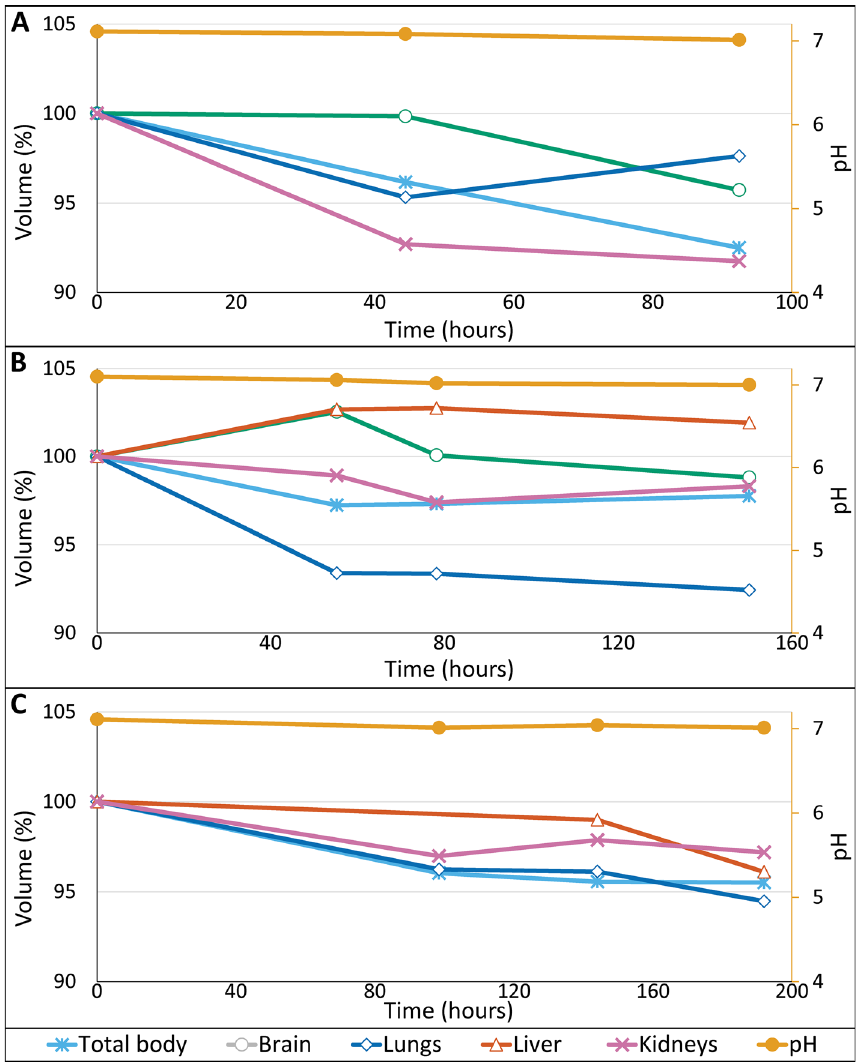
Figure 5. Three different human fetuses stained in 3.75% B-Lugol for a period of 90 to 190 h depending on fetal size. pH remained stable (red line) with a slight decrease from 7.1 to 7.0 (right Y-axis) during the entire staining procedure. ( A ) Fetus #1, 13 + 1 weeks of gestation (weeks + days), total length = 8 cm, weight = 17 g. ( B ) Fetus #2, 15 + 2 weeks of gestation, total length = 15 cm, weight = 58 g). ( C ) Fetus #3, 16 + 2 weeks of gestation, total length = 17 cm, weight = 85. In each of the fetuses, total body volume and almost all organ volumes showed only a limited shrinkage of between 0 and 5%. Only the total body and kidneys of fetus #1 ( A ) and lungs in Fetus #2 ( B ) showed, with 8%, slightly more